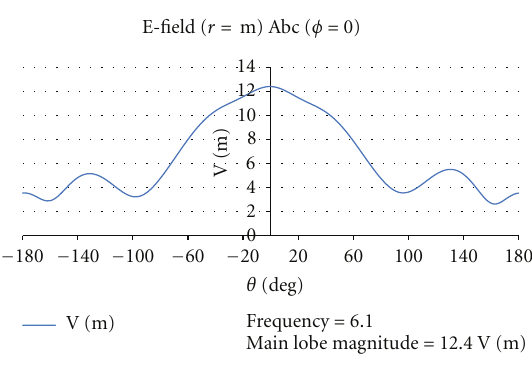
Figure 12: E-field pattern.